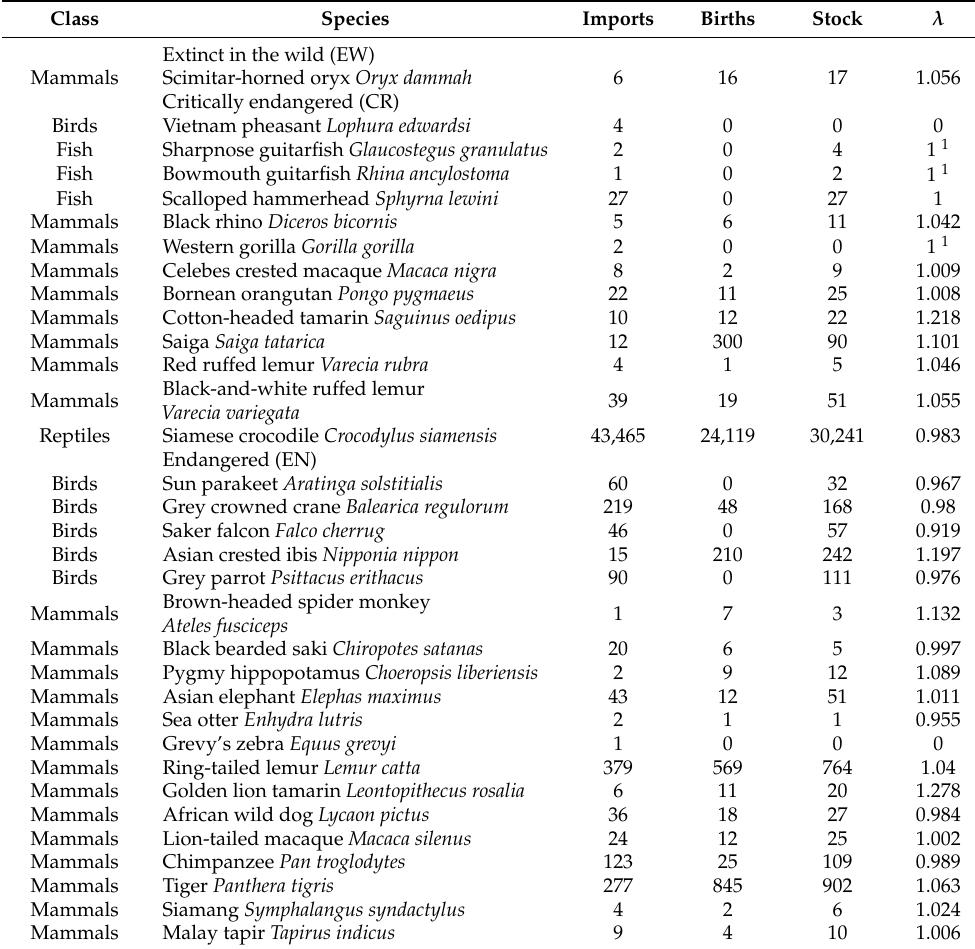
Table 2. Imported endangered species on the IUCN Red List (1996–2015) and present stocks (2017) in China, together with their respective finite rate of increase ( λ ). IUCN Red List of endangered species categories: endangered (EN), critically endangered (CR), and extinct in the wild (EW). Vulnerable (VU) species can be found in Supplementary Table